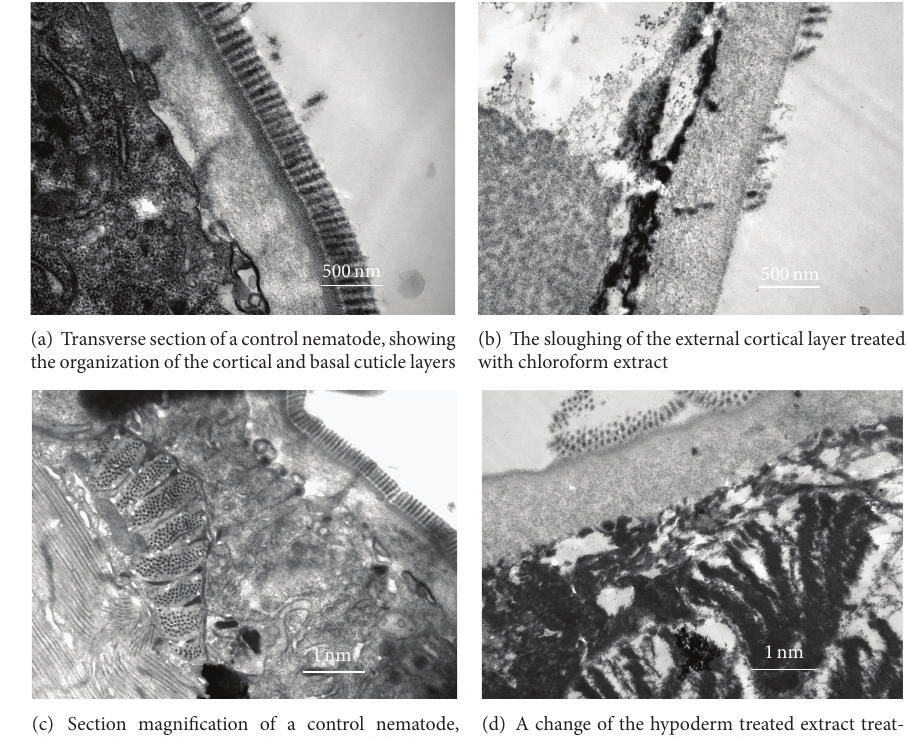
Figure 3: Transmission electron micrographs of cuticle and hypoderm of adult M.